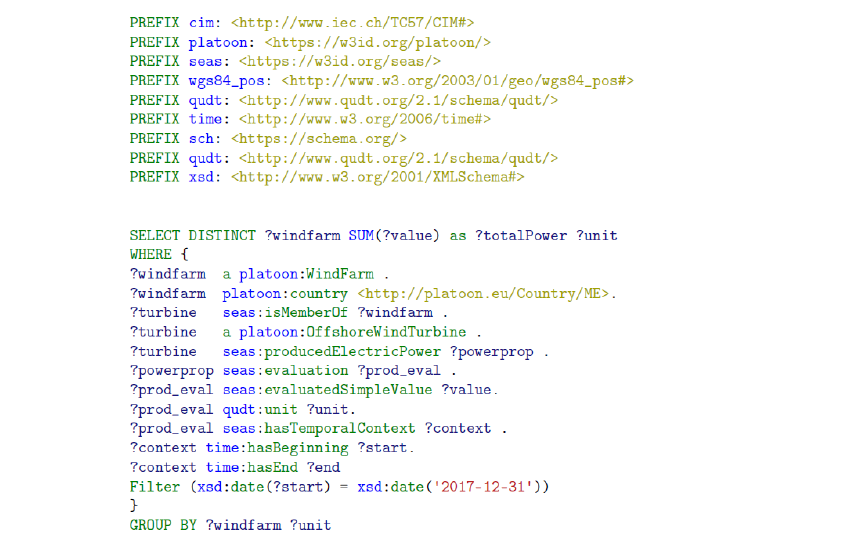
Figure 5. Example SPARQL